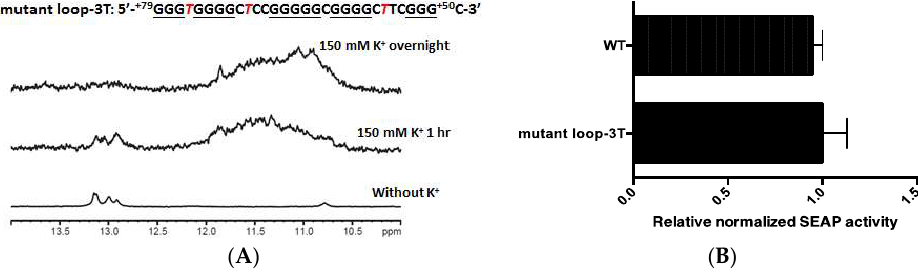
Figure 5. Strengthening of the PG4-3 structure. ( A ) The imino proton NMR spectra of the mutant CLIC4 loop-3T that did not affect the G4-forming motif. G-tracts are underlined and the mutation sites are marked in red italicized letters; ( B ) The SEAP activity in A375 was determined after 72 h of transfection of CLIC4 p(−125, +285) WT and the mutant loop-3T reporter plasmid. Data are expressed as the means ± SD of three replicates.